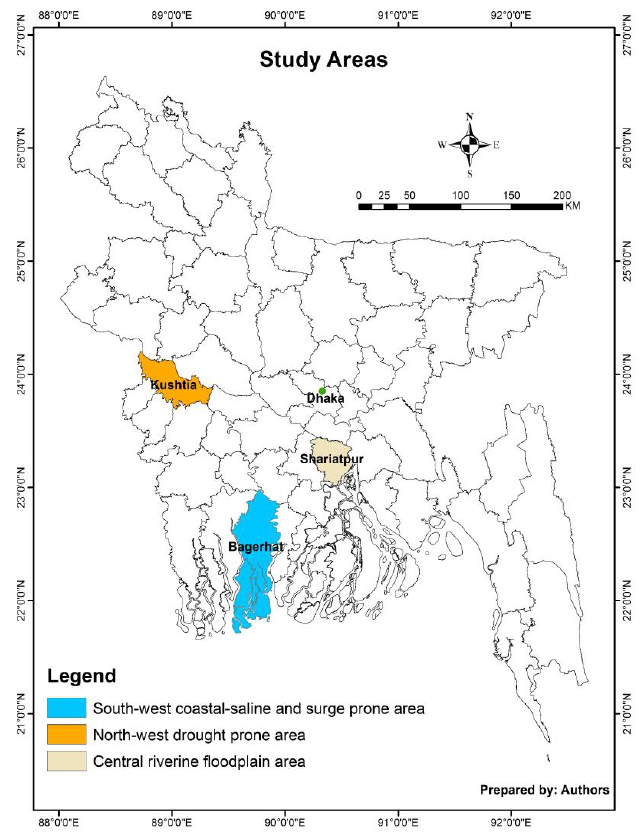
Figure 1. The map of Bangladesh showing the study areas.